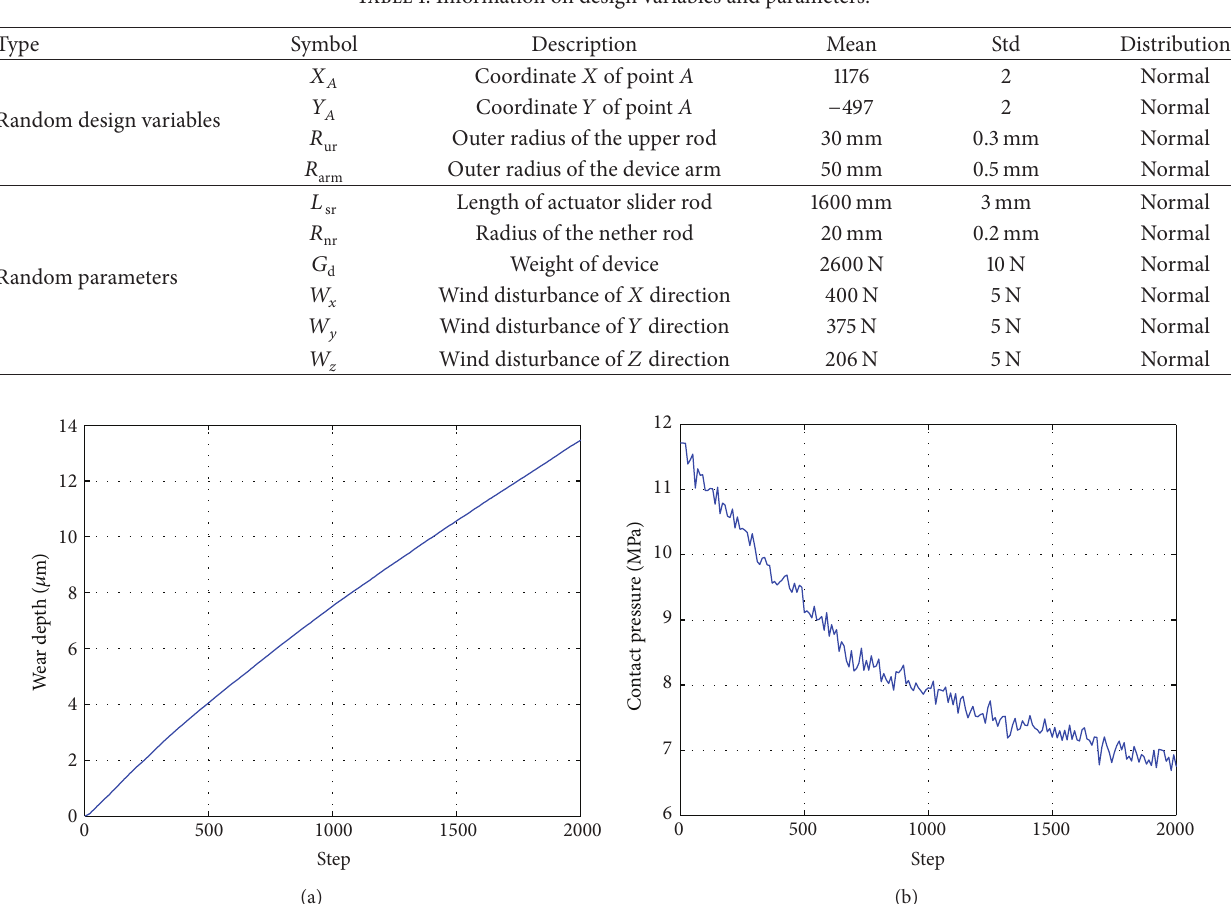
Table 1: Information on design variables and parameters.